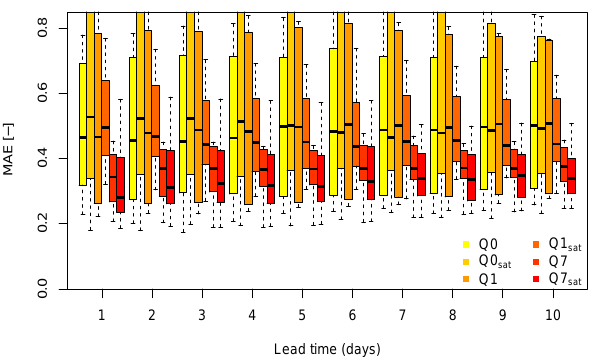
Figure 6. CRPS for different forecasting times for EFAS. Each box only contains the CRPS for the 16 validation locations for a period of 1year with two forecasts per day.